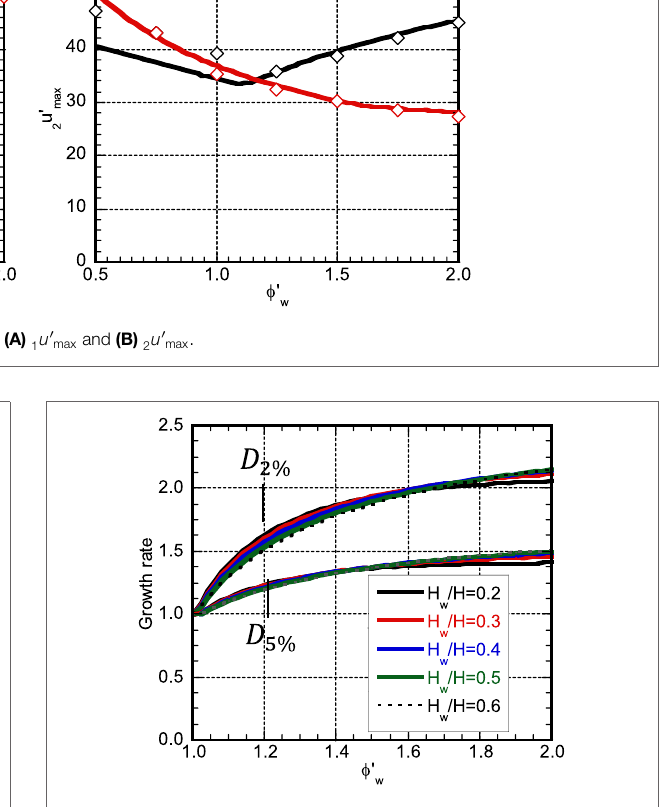
FIGURE 11 | Necessary damper deformation growth rate.